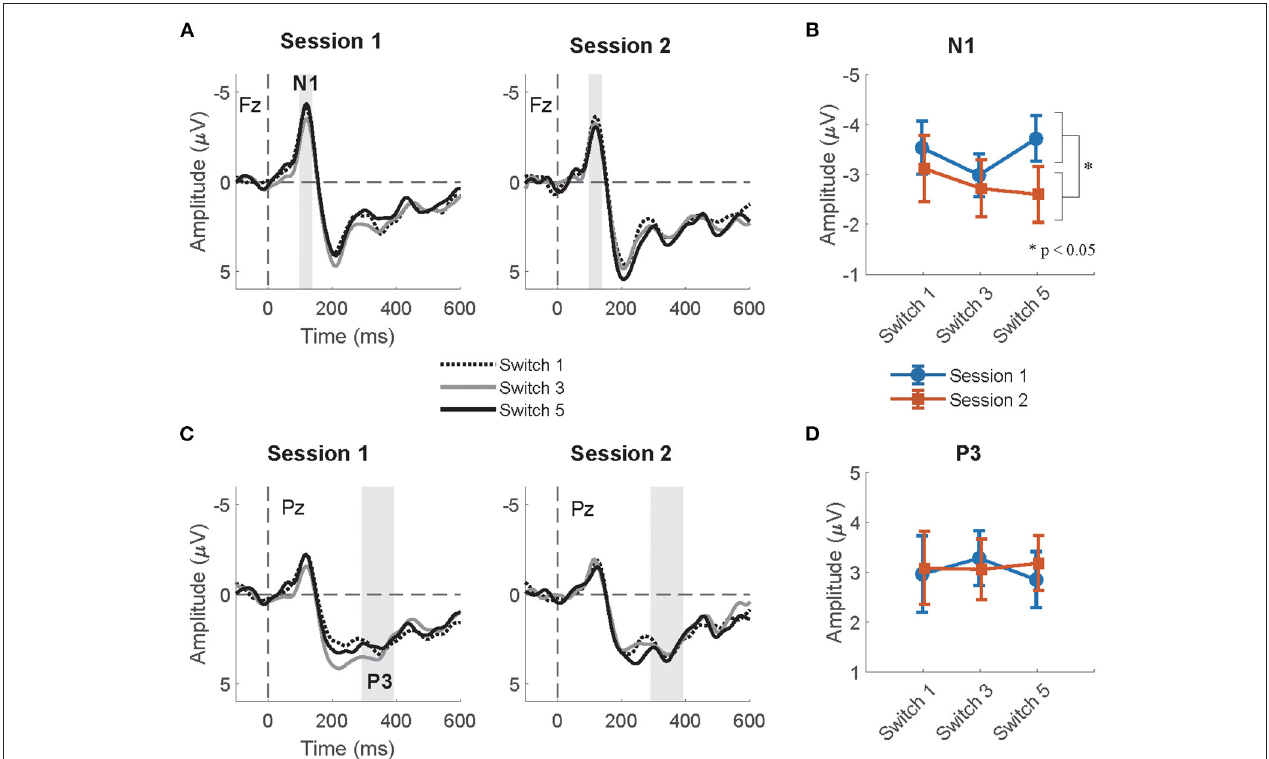
FIGURE 5 | (A) The grand-average ERP relative to feedback onset at Fz per session and switch type. The highlighted time window was used for the calculation of the mean amplitudes of N1. (B) The mean amplitude of the N1 relative to feedback onsets at Fz per session and switch type. (C) The grand-average ERP relative to feedback onset at Pz per session and switch type. The highlighted time window was used for the calculation of the mean amplitudes of P3. (D) The mean amplitude of the P3 relative to feedback onsets at Pz per session and switch